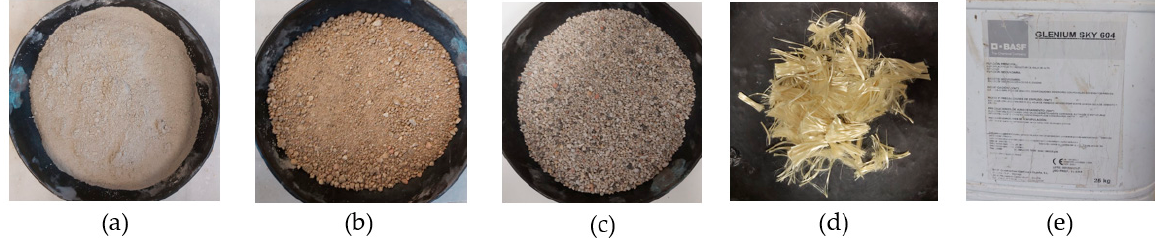
Figure 1. Materials used. ( a ) Cement type CEM II/B-L-32.5; ( b ) natural aggregate (NA); ( c ) recycled concrete aggregate (RA-Con); ( d ) aramid fiber; ( e ) Glenium Sky 604 superplasticizer.